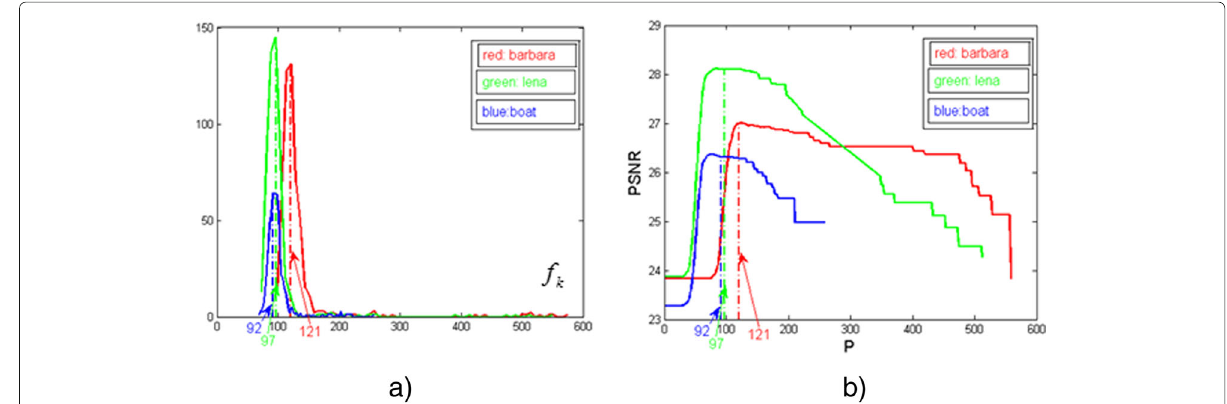
Fig. 3 The insensitivity of the threshold P . a Histograms of f k . b PSNR of ˆ S P with respect to